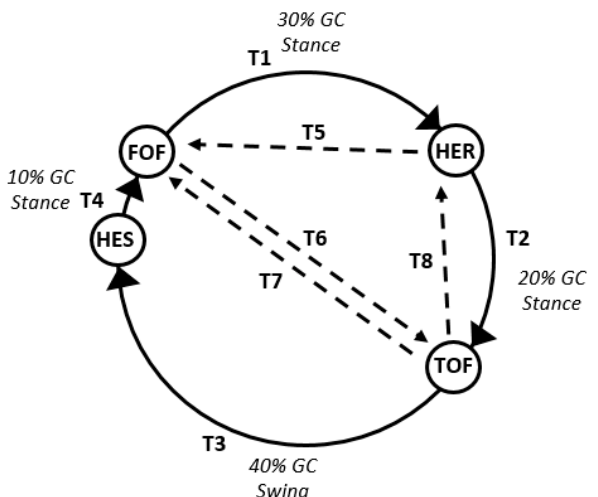
Figure 4. The core workflow of the developed gait event detection algorithm (based on [39] transition of states).